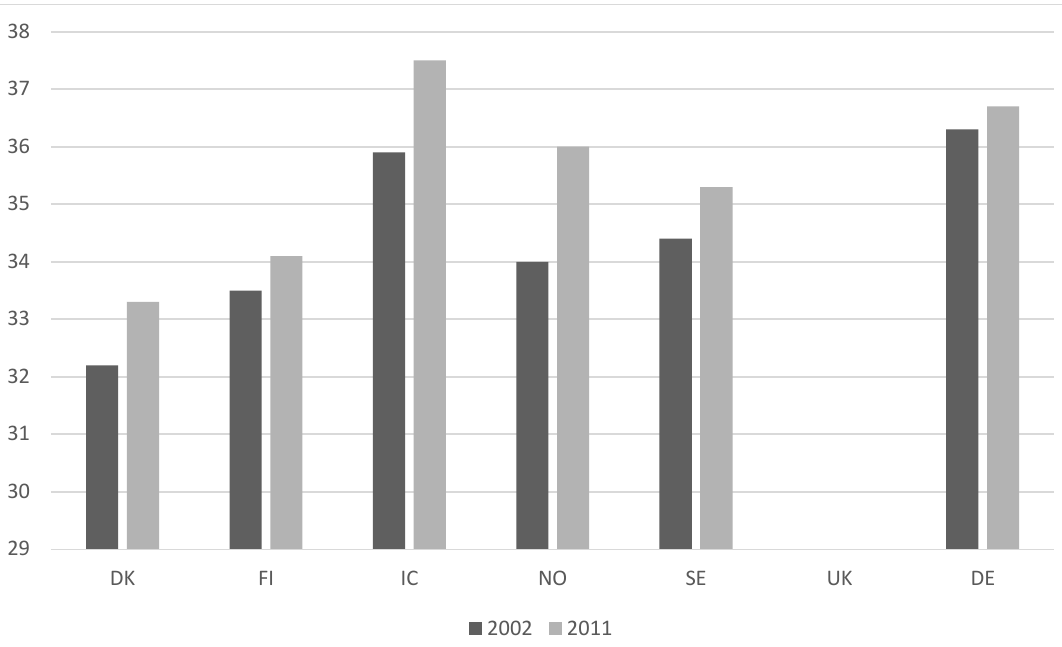
Figure 4: Overweight as share of the population in the Nordic countries and Germany, 2002 and 2011